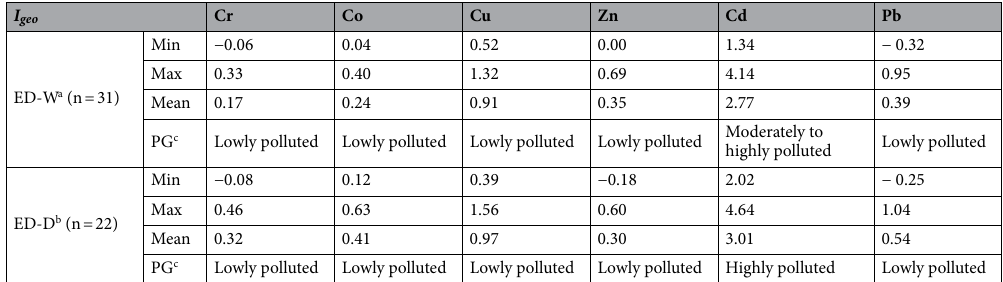
Table 3. The I geo value and series of six heavy metals in sediments from the East Dongting Lake in the wet and dry seasons. a East Dongting Lake in the wet season. b East Dongting Lake in the dry season. c Pollution